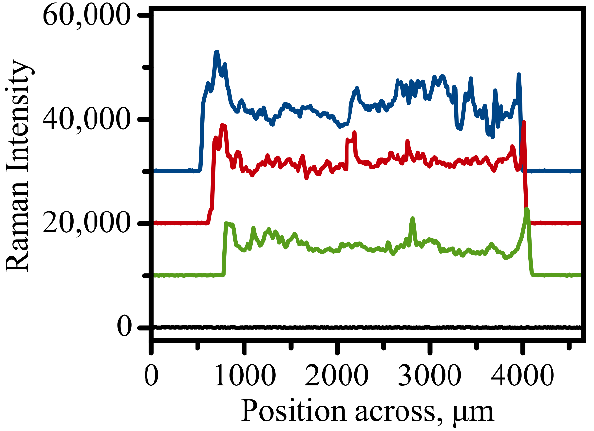
Figure 3. Three representative scans of Raman signal variation when a 3 mm address is scanned across utilizing automated measurements. Intensity was evaluated for the 1336 cm − 1 peak of the NBT molecule. Black line shows background signal variation measured on an empty unmodified spot on the golden slide.